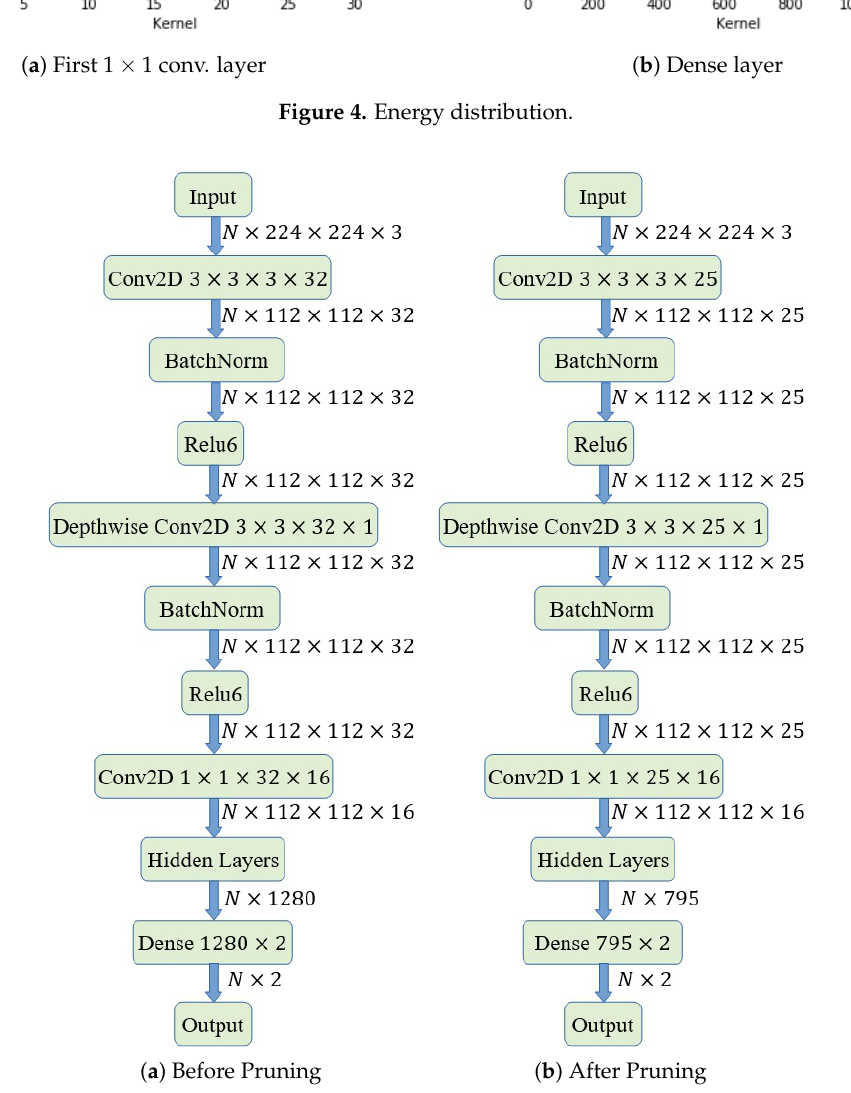
Figure 5. Pruning graph, “ N ” is batch